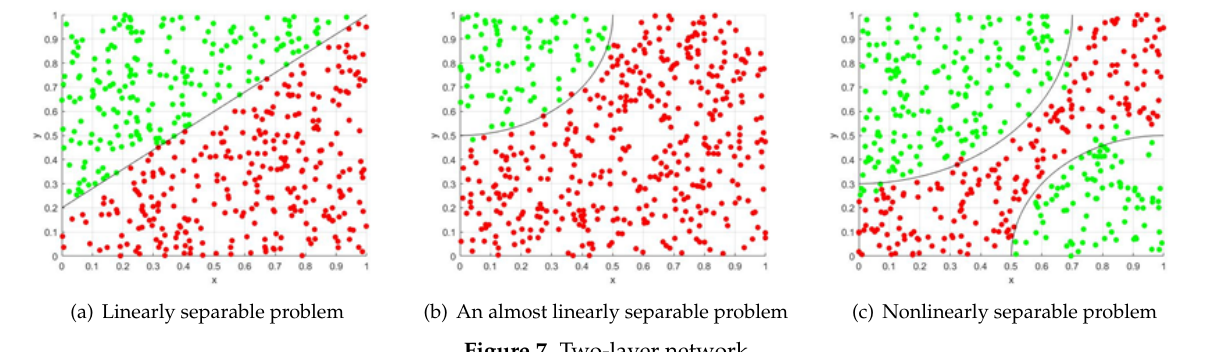
Figure 7. Two-layer